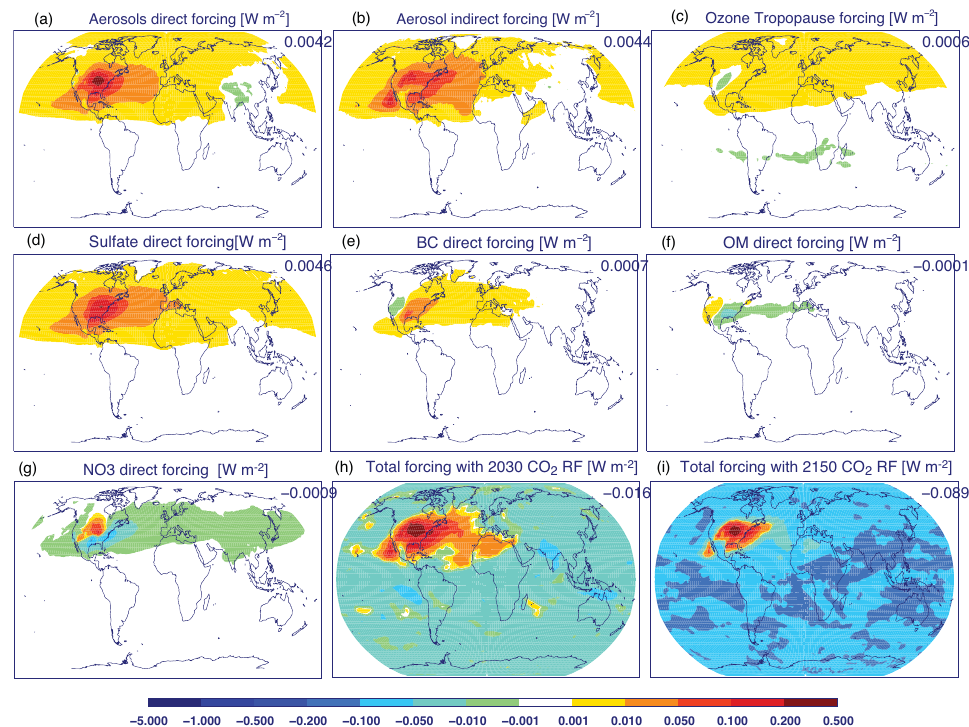
Figure 10. Impact of the CO 2 reduction policy (CO 2 30) on radiative forcing in 2030 relative to 2005.